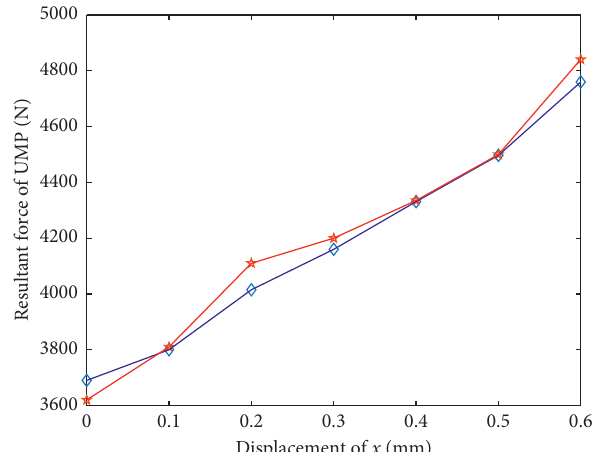
Figure 7: The diagram of UMP trend under the eccentricity change in direction x .